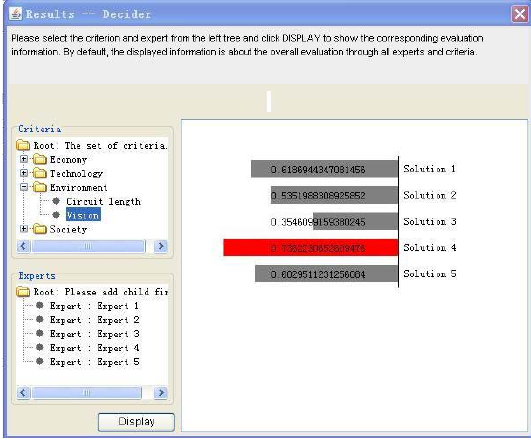
Fig.13. Ranking result for solutions under the criterion